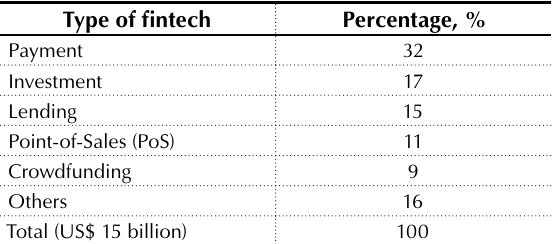
Table 2. Fintech transactions in